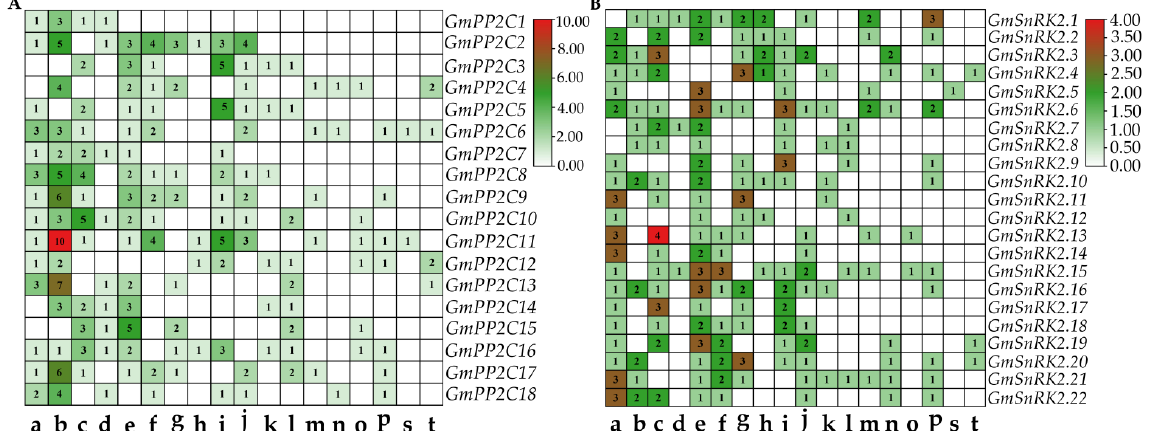
Figure 4. Cis -elements in the promoters of GmPP2C-A ( A ) and GmSnRK2 ( B ) are related to hormone and stress responses. The bar indicates the number of cis -elements. The numbers 1, 2, 3, … represent the number of repeats of each cis -element, whereas 0 indicates absence of a particular cis -acting element. Letters a, b, c, … represent cis -elements. a: MBS (CAACTG, MYB-binding site involved in drought inducibility); b: ABRE (TACGTG, ABA response element); c: ARE (TGGTTT, anaerobic in-